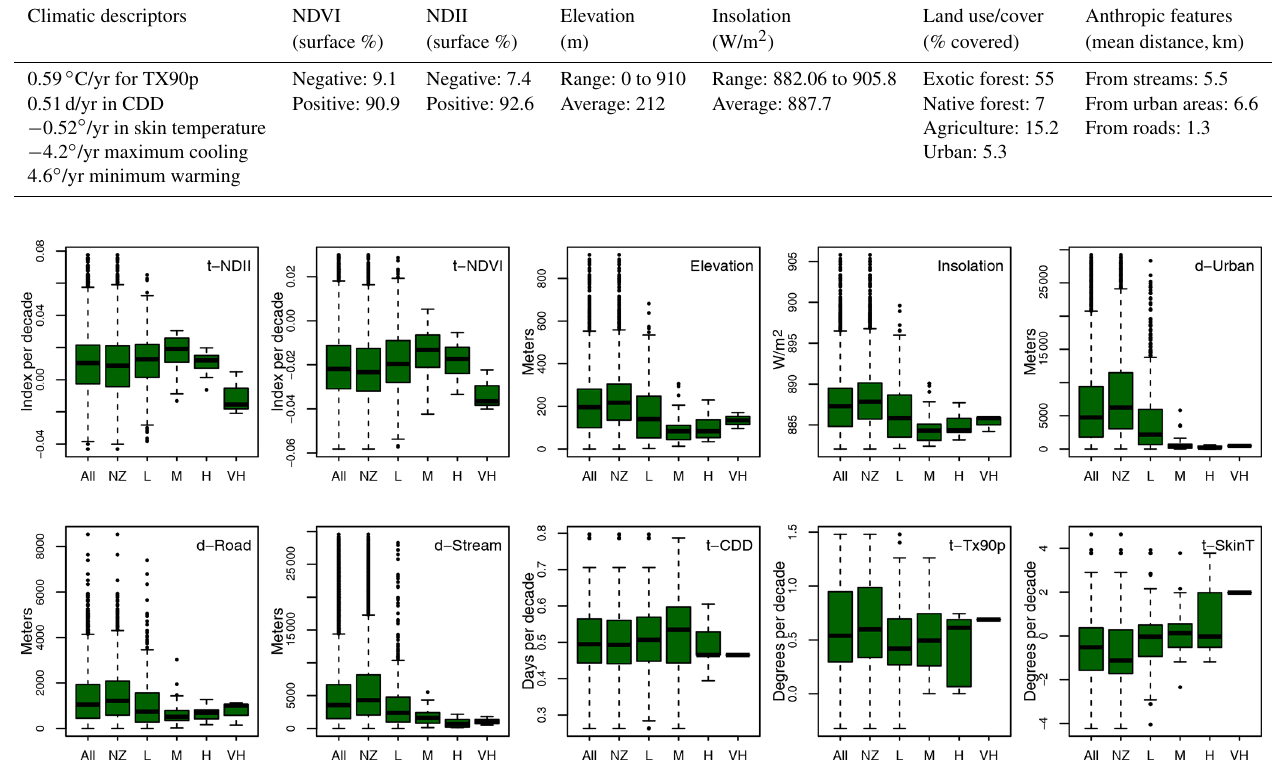
Figure 2. The main features of the variables in the geodatabase, grouped according to the wildfire categories: near zero (NZ), low (L), moderate (M), high (H), and very high (VH). Units of temperature are degrees Celsius.